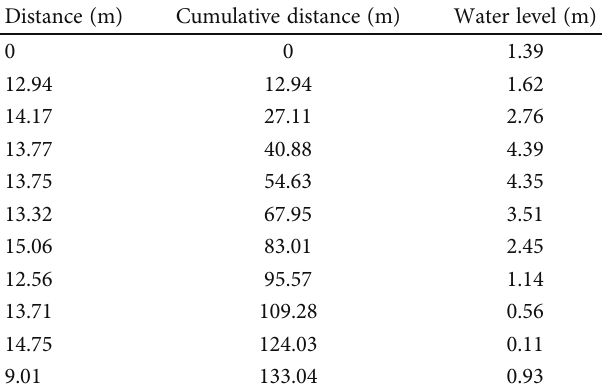
Table 6: Water level for bottom outlet using theoretical calculations.